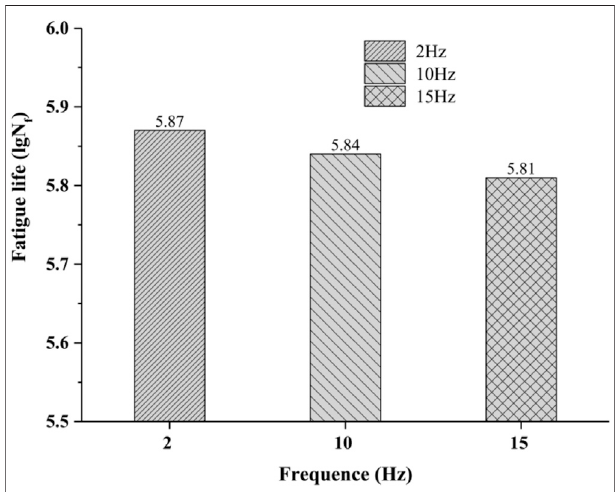
FIGURE 8 | Effect of loading frequency on the fatigue